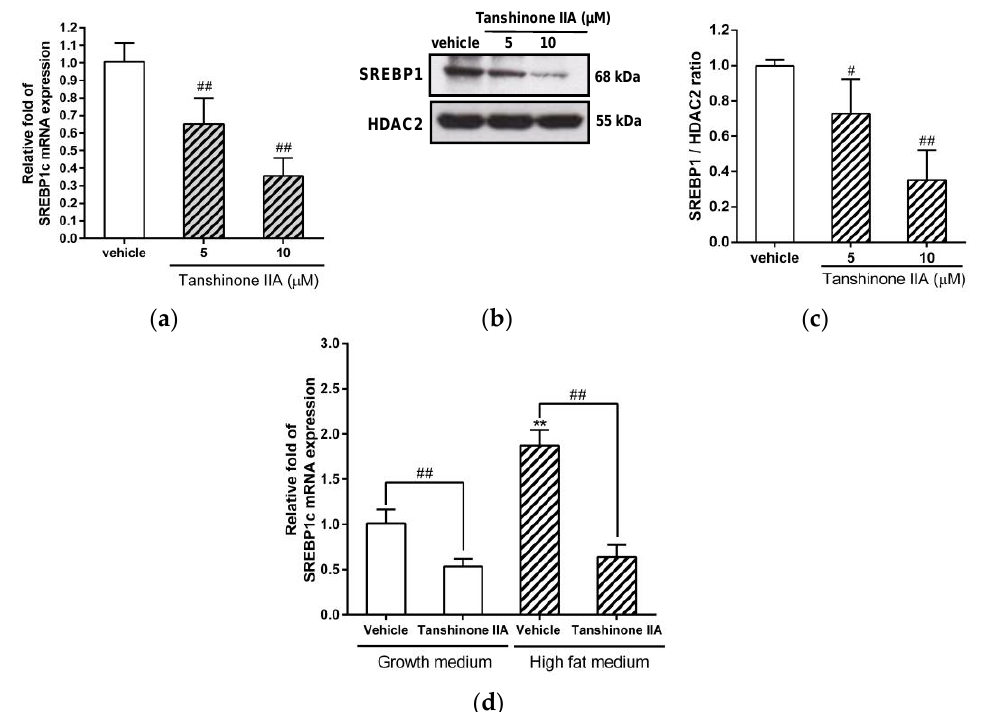
Figure 6. Effects of tanshinone IIA on SREBP1 gene expression. HepG2 cells were treated with vehicle (0.1% DMSO) or tanshinone IIA (5 and 10 µ M) for 24 h. ( a ) The mRNA expression of SREBP-1c was measured by RT-qPCR analysis. The data represent the mean ± SD of three independent experiments. ## p < 0.01 indicates significant differences compared to the vehicle-treated cells. ( b ) Nuclear extracts were prepared from vehicle- or tanshinone-IIA-treated cells, and the level of nuclear SREBP1 protein was analyzed by Western blot analysis. A representative blot is shown. ( c ) The normalized intensity of SREBP1 protein versus HDAC2 is presented as the mean ± SD of three independent experiments. # p < 0.05 and ## p < 0.01 indicate significant differences compared to the vehicle-treated cells. ( d ) HepG2 cells were treated with vehicle (0.1% DMSO) or tanshinone IIA (10 µ M) in normal growth medium or high-fat medium. The mRNA expression of SREBP-1c was measured by RT-qPCR analysis. The data represent the mean ± SD of three independent experiments. ** p < 0.01 indicates significant differences compared to the vehicle-treated cells incubated with growth medium. ## p < 0.01 indicates significant differences compared to the vehicle-treated